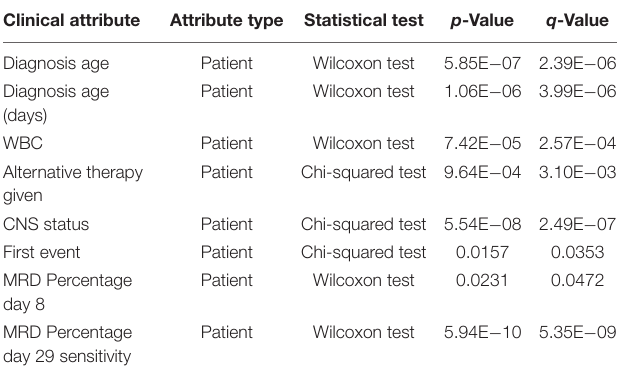
TABLE 3 | Comparison of clinical attributes of ADAM6 homozygous deletion (ADAM6:HOMDEL) versus ADAM6 wild-type (WT:ADAM6) patients. Clinical